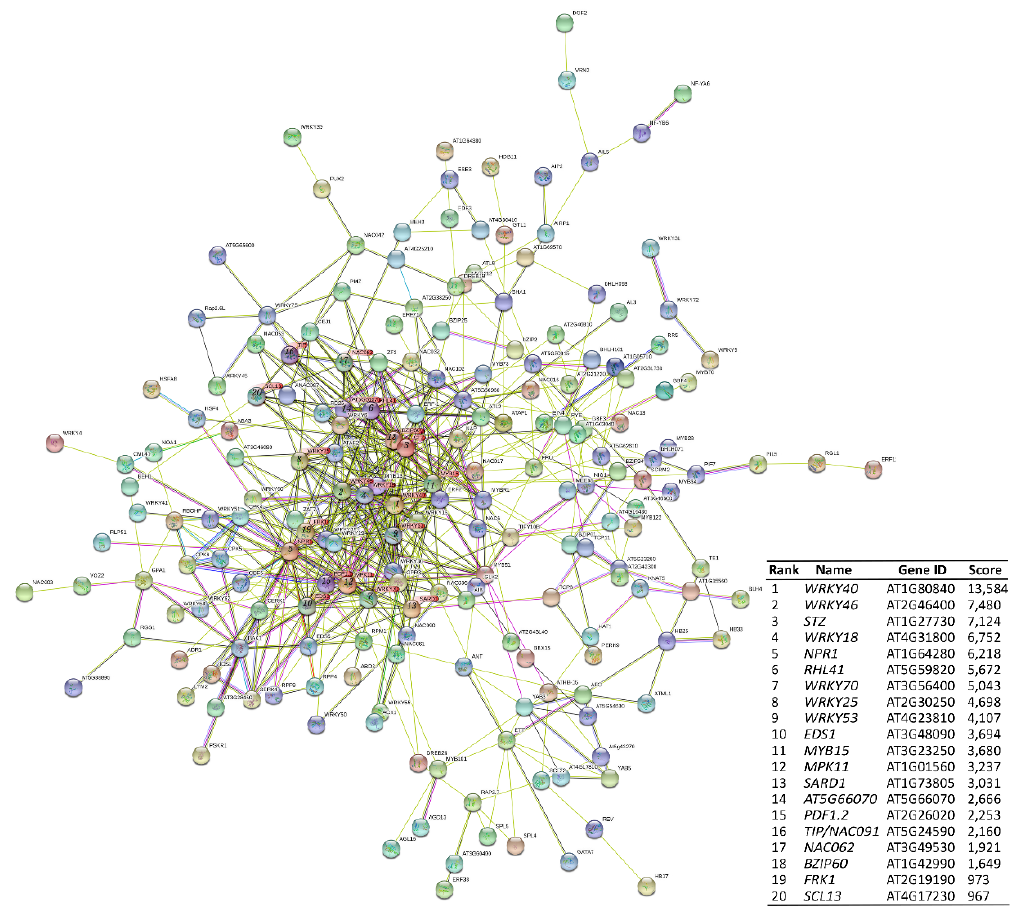
Figure 4. Protein–protein interaction network highlighting hub genes involved in plant–pathogen interaction in Arabidopsis . The most important hubs are ranked based on their importance in the network.